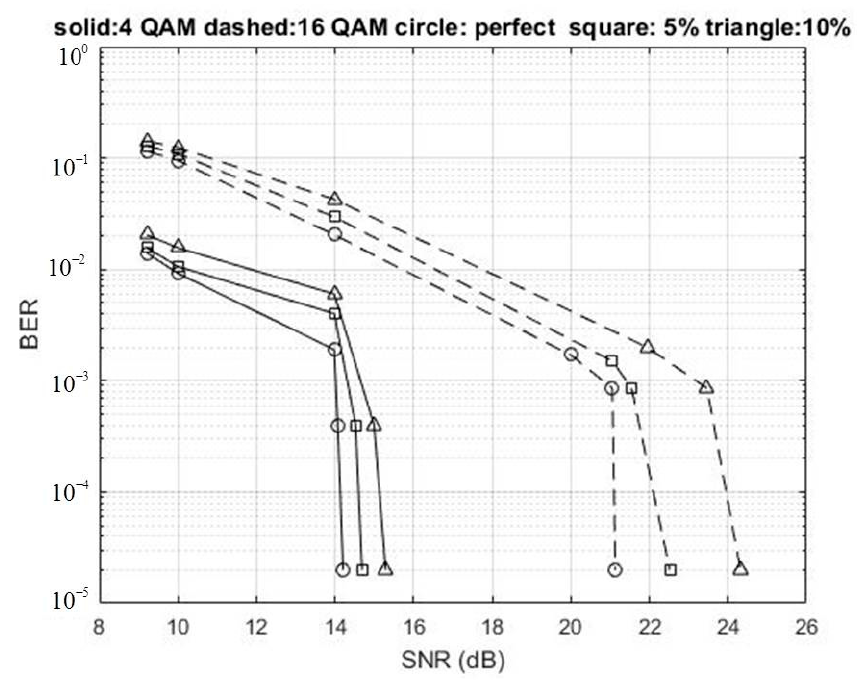
Figure 2. Quadrature amplitude modulation (QAM) bit error rate (BER) performances of the UFMC-based underwater transceiver with an LDPC code, a perfect channel estimation (PCE) and channel estimation errors (CEEs) of 5% and 10%.